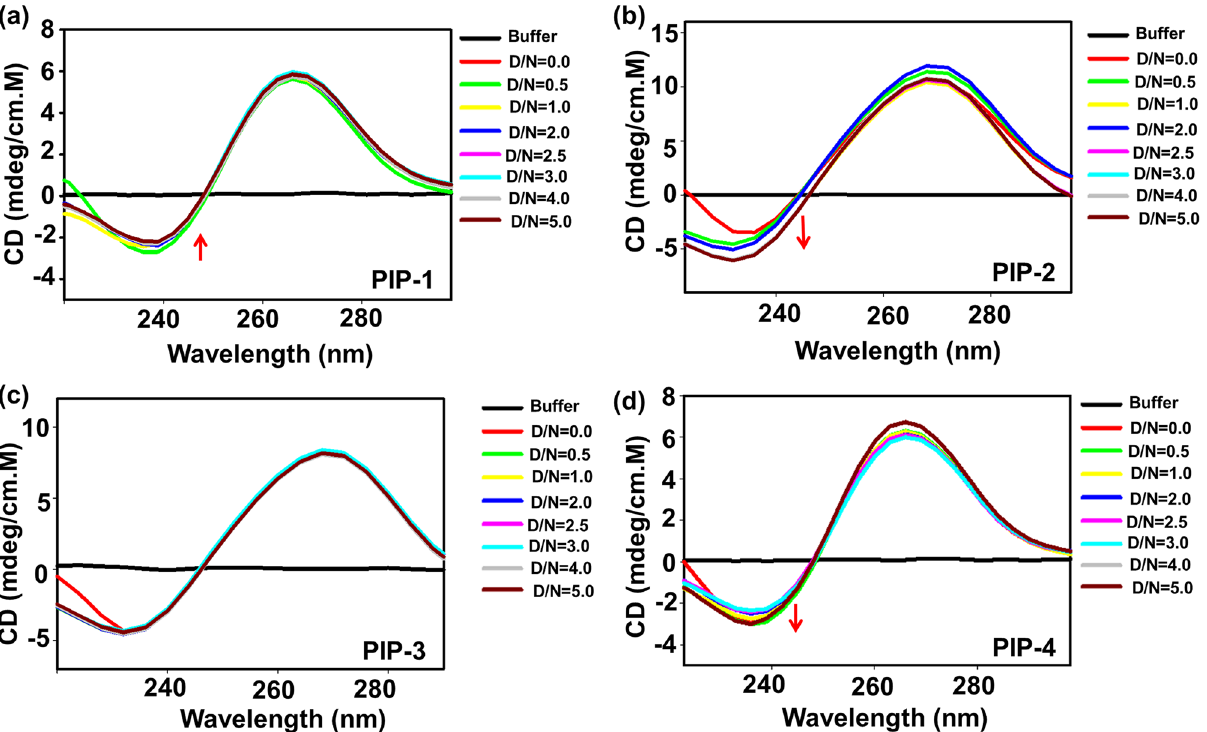
Figure 6. CD spectra profile of c-myc G4 DNA with Piperine analogs. CD spectra of free (10 µM) c-myc G4 DNA and its complex with successive addition of different Piperine analogs ( a ) PIP-1 ( b ) PIP-2 ( c ) PIP-3, and ( d )